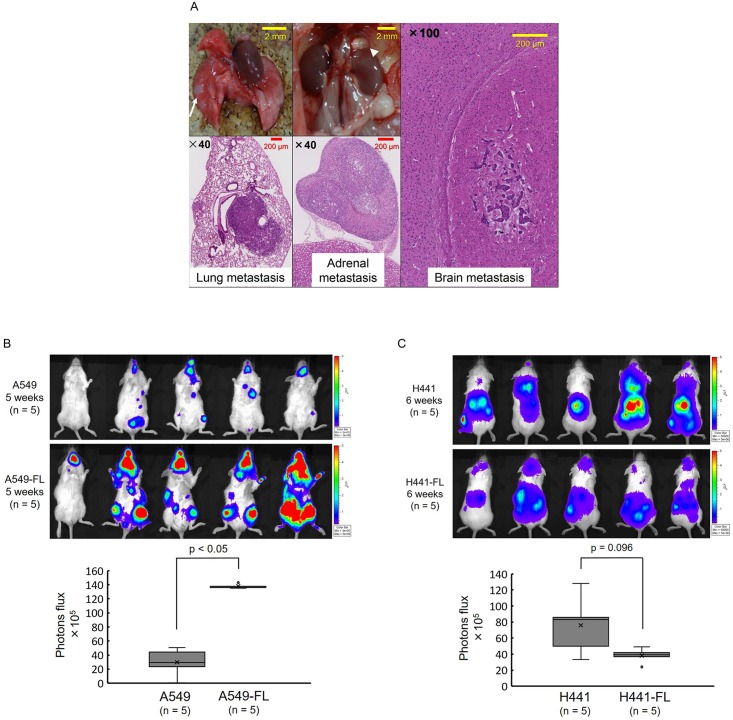
Metastatic tumor formation after an intracardiac injection of parental and FL cells.(A) Metastatic tumors were formed in multiple organs in all mice injected with parental or FL cells. Representative macroscopic and microscopic pictures are shown of lung (white arrow), adrenal (white arrow head), and brain metastases of luc-A549 cell lines. (B) In vivo luciferase imaging of luc-A549 cell lines and luc-A549-FL sublines at 5 weeks post-implantation. Representative images from ventral view are shown. Quantification of tumor-derived photons at 5 weeks post-implantation. Data are shown as the mean ± standard deviation of the photon flux of 5 animals. The Luc-A549-FL subline showed markedly greater metastatic tumor growth than luc-A549 cells. (C) In vivo luciferase imaging of luc-H441 cell lines and luc-H441-FL sublines at 6 weeks post-implantation. Representative images from dorsal view are shown. Quantification of tumor-derived photons at 6 weeks post-implantation. No significant differences were observed in tumor-derived photons between luc-H441 and luc-H441-FL cells. Data are shown as the box-and-whisker plot of the photon flux of 5 animals. Statistical analysis was performed by the Mann-Whitney U test.